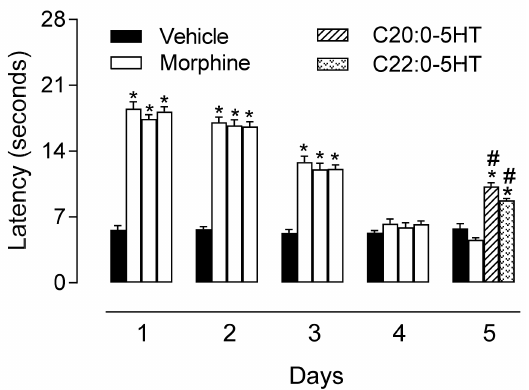
Figure 7. Antinociceptive effect of β N -arachinoyl-5-hydroxytryptamide (C 20:0 -5HT) and β N - behenoyl-5-hydroxytryptamide (C 22:0 -5HT) in morphine-tolerant mice were evaluated using a hot plate model for 5 consecutive days. Morphine (50 mg/kg, i.p.) was administrated to mice every 24